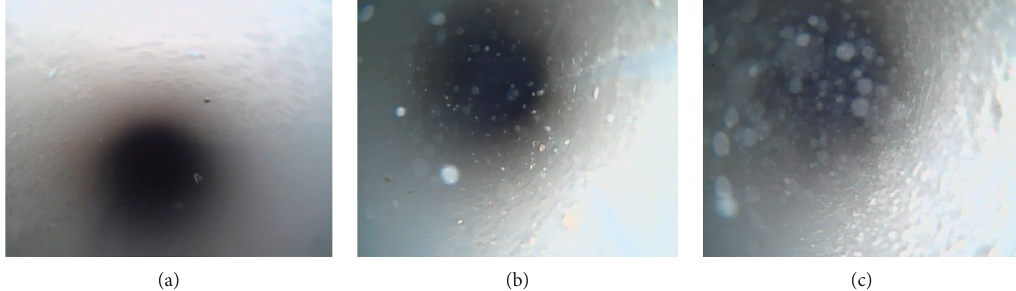
Figure 9: Polyvinyl chloride pipe. (a) October 28, 2016. (b) January 28, 2017. (c) April 28, 2017.